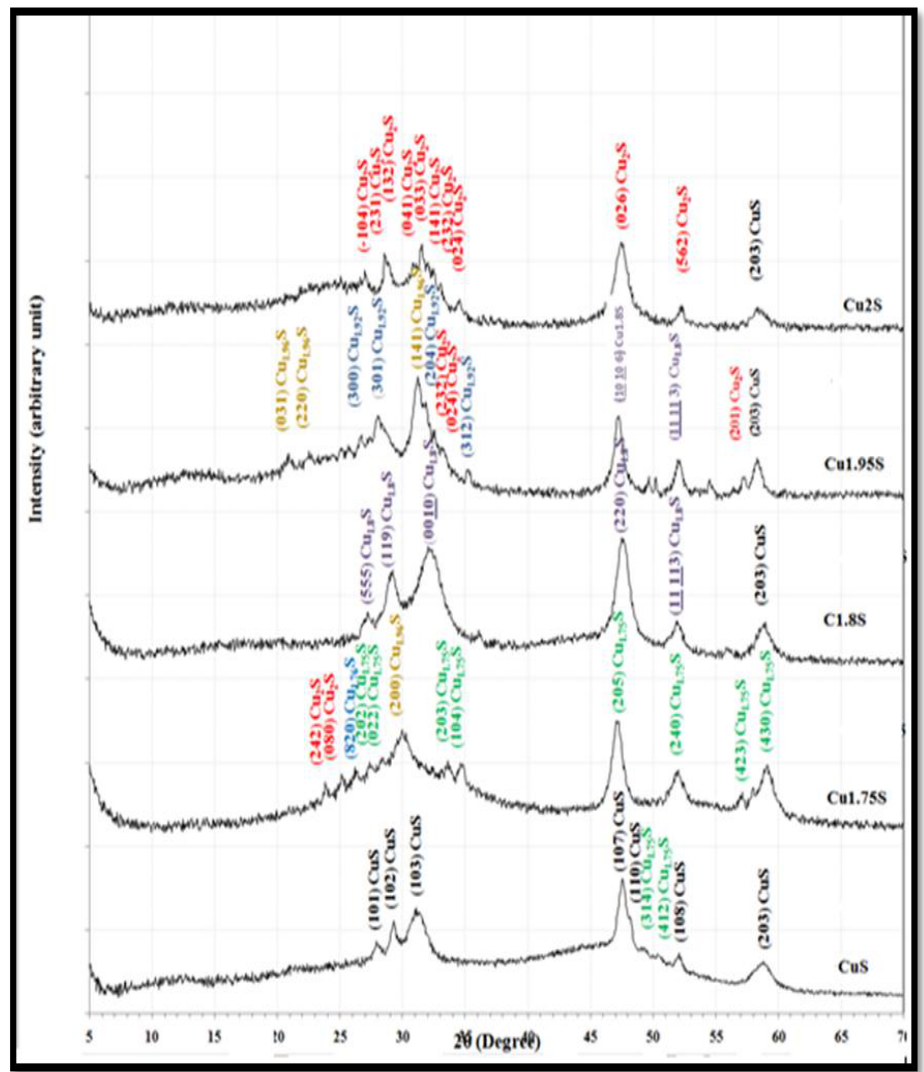
Fig. 3: Crystal structure of Cu